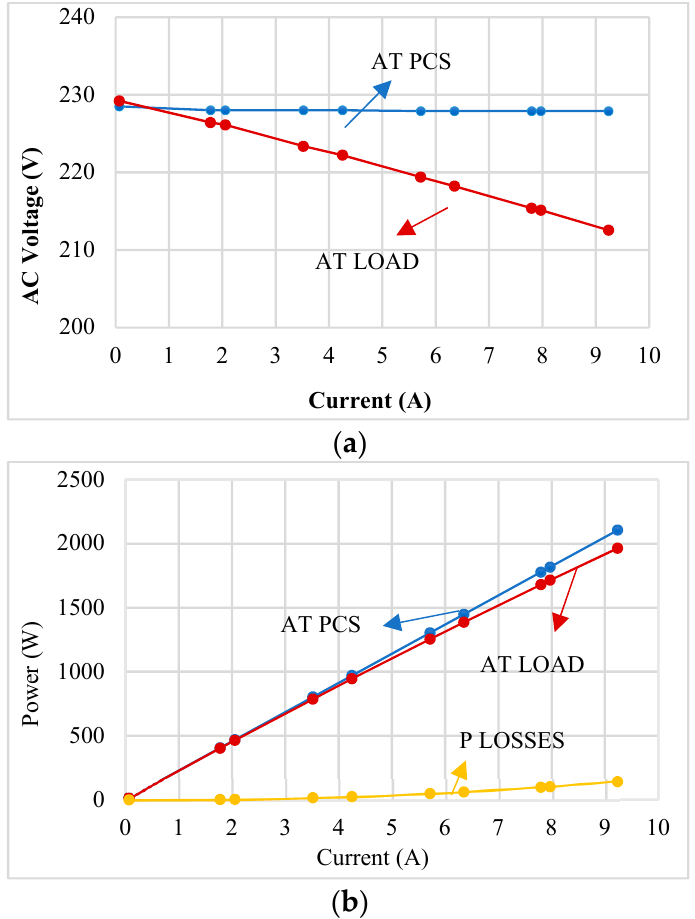
Energies 2021 , 14 , x FOR PEER REVIEW Figure 9. Field testing results: ( a ) Voltage drop on cable, and ( b ) losses on cable.